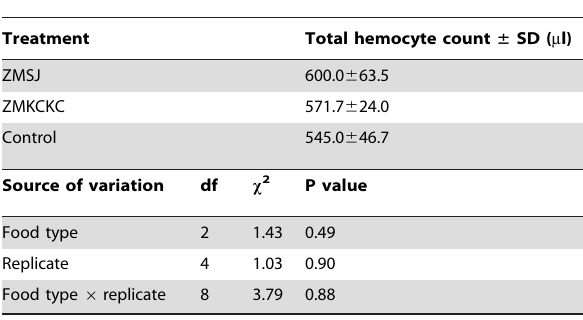
Table 4. Mean total hemocyte count of honey bees from groups subjected to chronic exposure to ZMSJ pollen, ZMKCKC pollen and non-Bt pollen after 7 days.